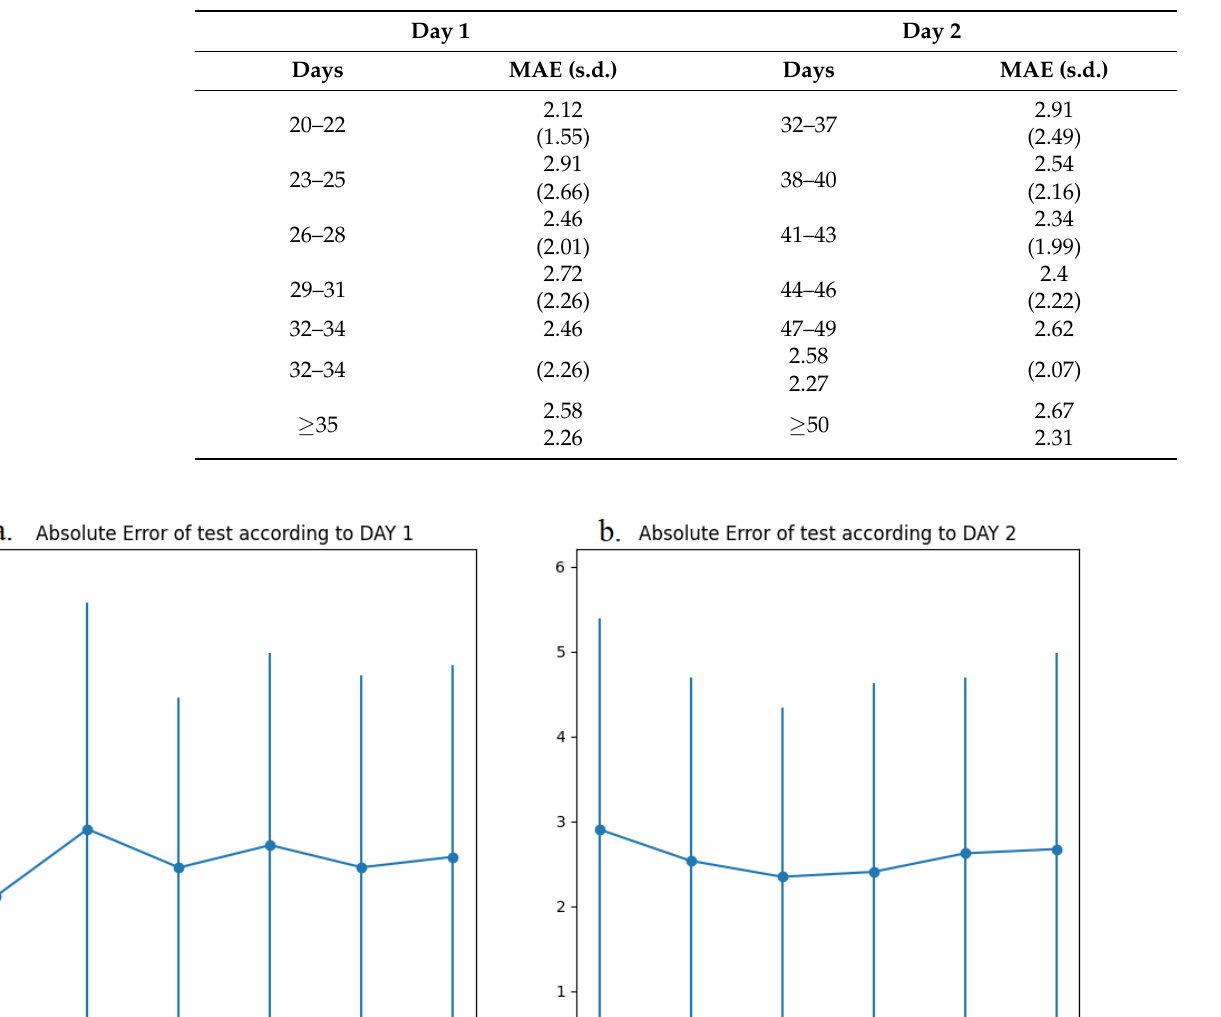
Table 4. Testing MAE with s.d. values for 3-day intervals’ groups in: Day 1, Day 2.